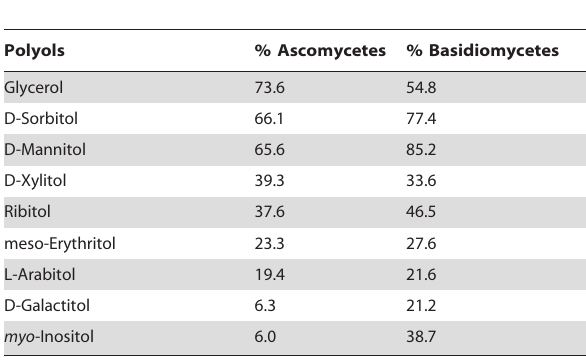
Table 1. Prevalence of polyol assimilation by yeasts (based on